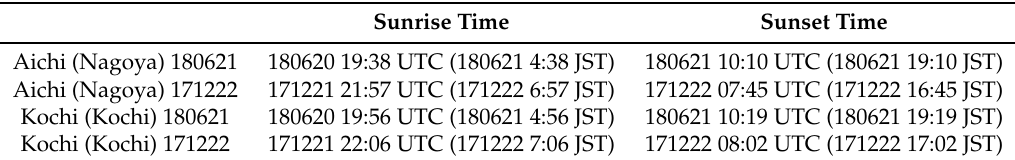
Table 10. Sunrise and Sunset times in the ROIs during the summer and winter solstices [51]. Dates are represented by six digits: